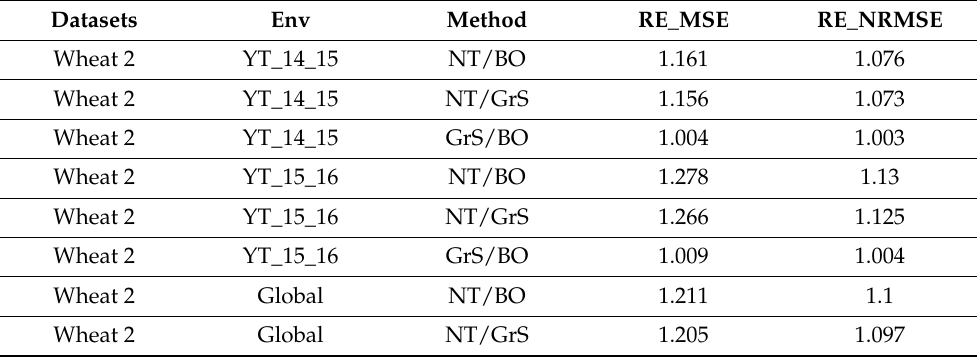
Table A4. Prediction performance for each environment and across environments (Global) of dataset 2 in terms of their relative efficiencies (RE) under two metrics (MSE and NRMSE). In the column method we represent the two tuning strategies that were used to compute RE_MSE and RE_NRMSE.